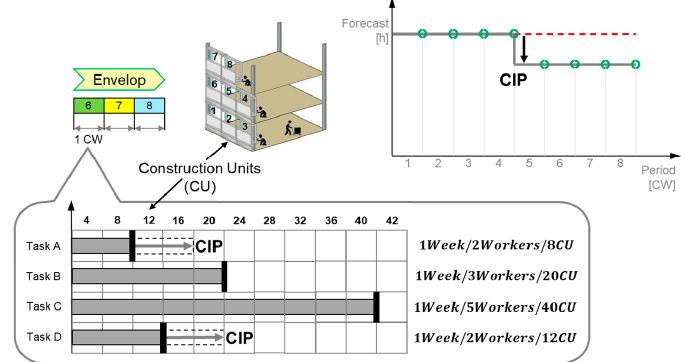
Figure 6. Pitches as enablers for real-time planning and monitoring in ETO construction.